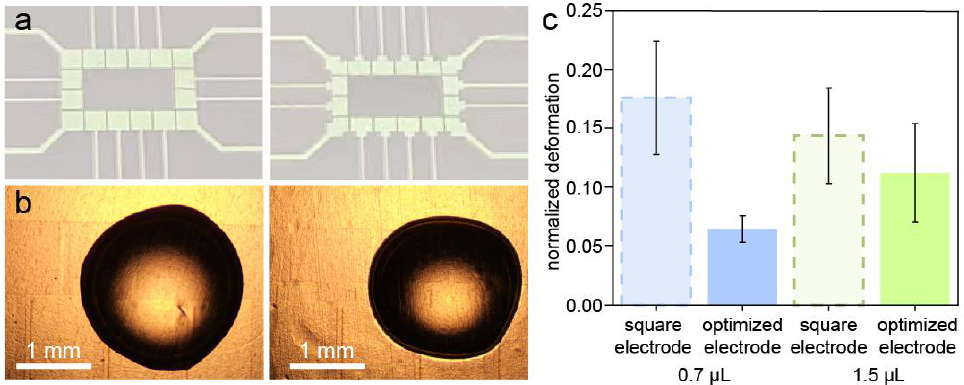
Figure 5. ( a ) Photos of the fabricated ITO-DMF chip with square electrode (left) and optimized electrode (sc-electrode, right); ( b ) the microscopic images of the droplet (1.5 µ L) as actuated by the square electrode (left) and optimized electrode (right); ( c ) the normalized deformation of the droplets (0.7 μL and 1.5 μL) as measured based on the microscopic images ( N = 10).